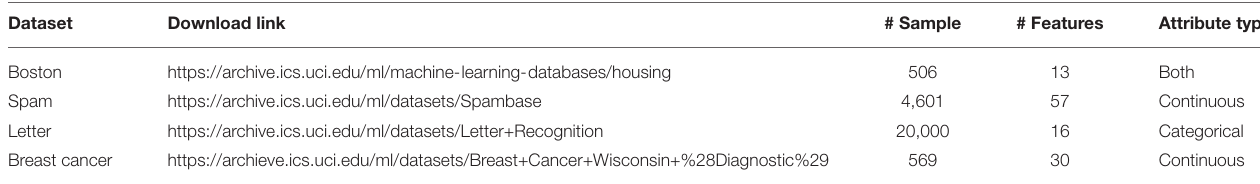
TABLE 1 | The Boston data have information for predicting the value of house prices; the spam data contain the attributes to determine whether e-mails spam; the letter data have character image features to identify a letter of the alphabet; the breast cancer data gathered the numerical features of cell images for tumor diagnosis.